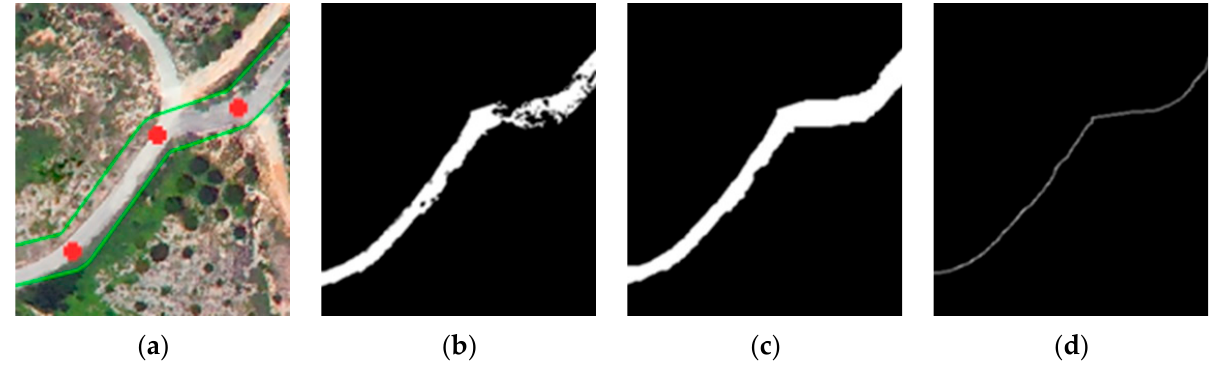
Figure 3. Road skeleton extraction: ( a ) test image, where seed points are shown in red; ( b ) regional growth result; ( c ) closing operation result; ( d ) thinning result.